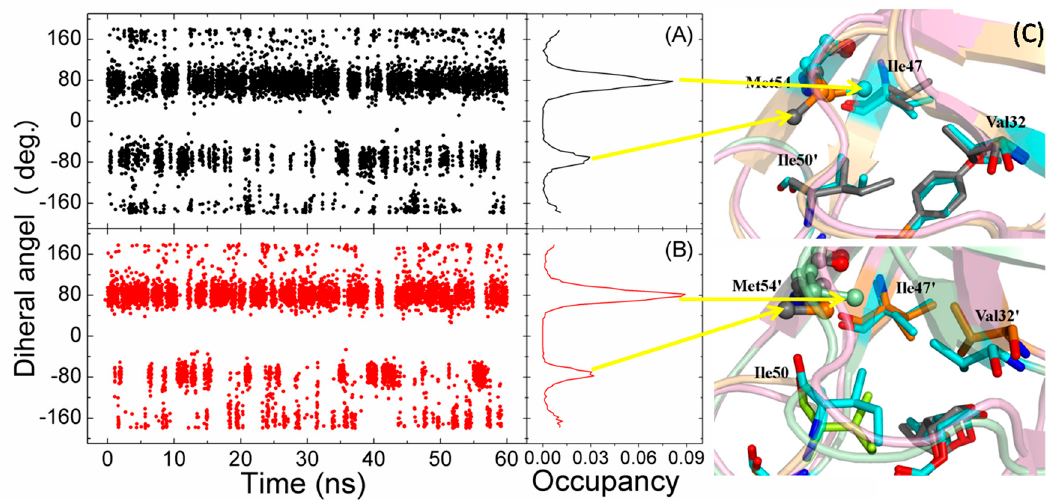
Figure 7. Dihedrals of the four heavy atoms of the side chain of residues 54 in chain A with black line ( A ) and in chain B with red line ( B ); ( C ) The major and the minor conformations are shown, and the heavy atoms of the side chain of residue 54 are shown in ball representation. The representation is the same as in Figure 5.